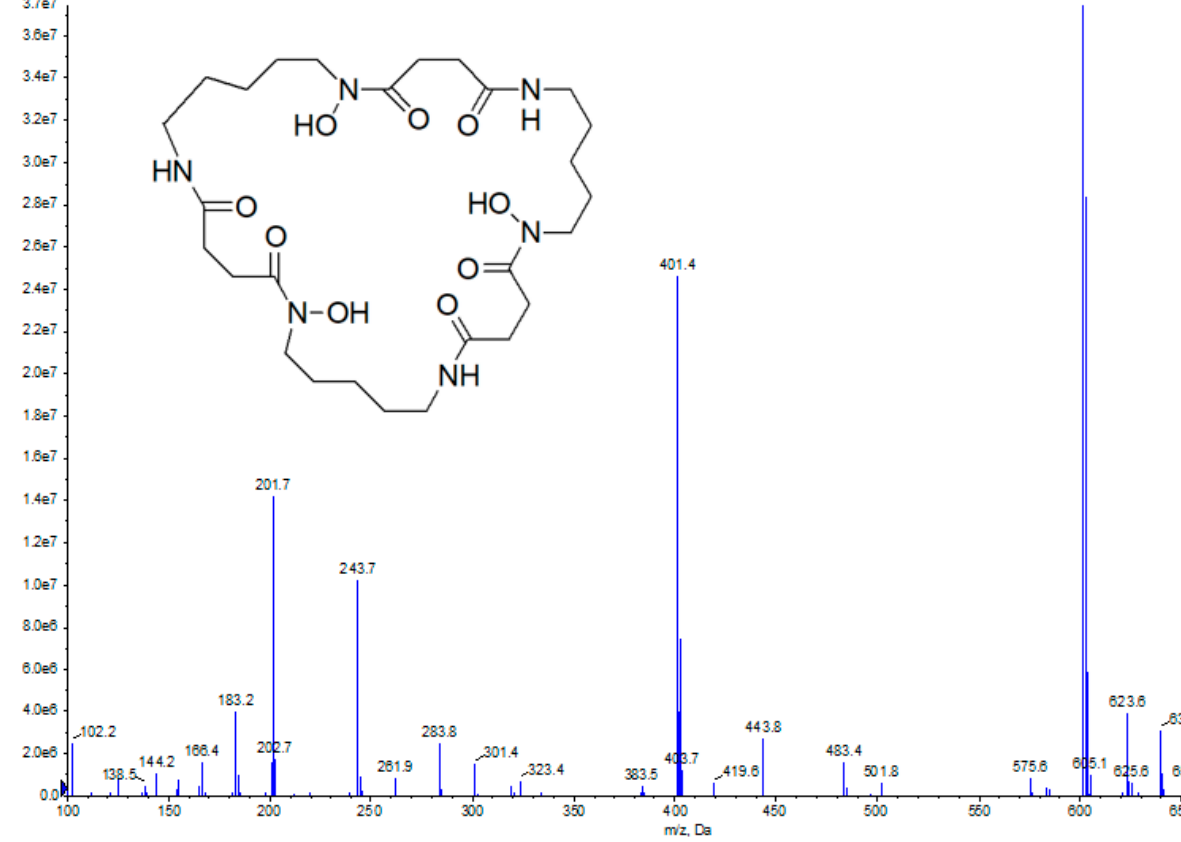
Figure 2. UPLC-MS analysis of H11809-CCF9.